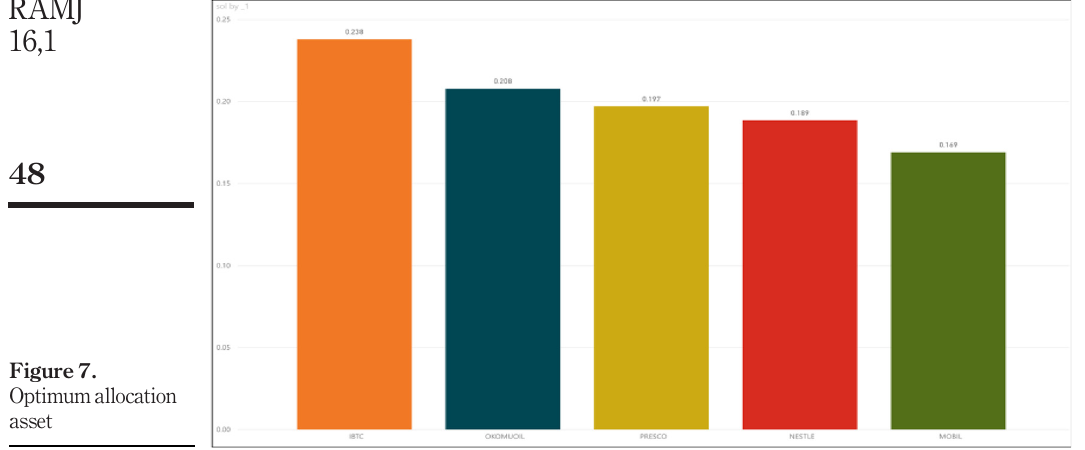
Figure 7. Optimum allocation